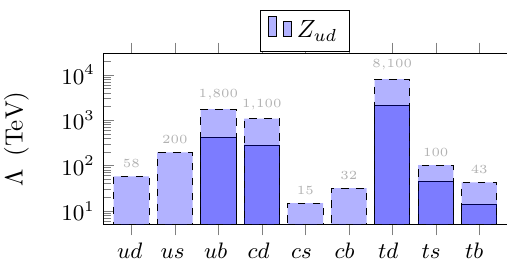
Figure 5 . The (cid:12)gure summarizes the most stringent constraints on the scale of the S 1 leptoquark, assuming Z ud = 1 = (cid:3) 2 . The dashed bars show the constraints obtained using the ‘central’ strategy while the solid lines indicate those obtained in the ‘R-(cid:12)t’